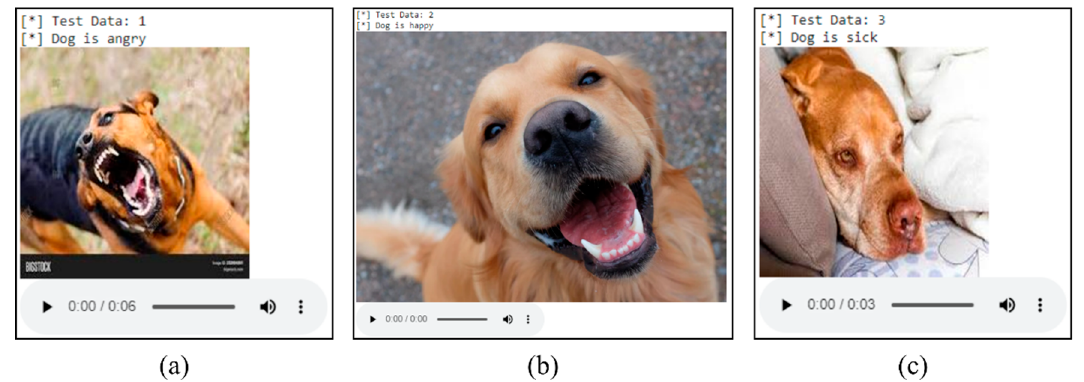
Figure 20. Samples of test data (angry, happy, and sick) using the weighted average technique. The outputs shows ( a ) Dog is angry, ( b ) Dog is happy and, ( c ) Dog is sick.